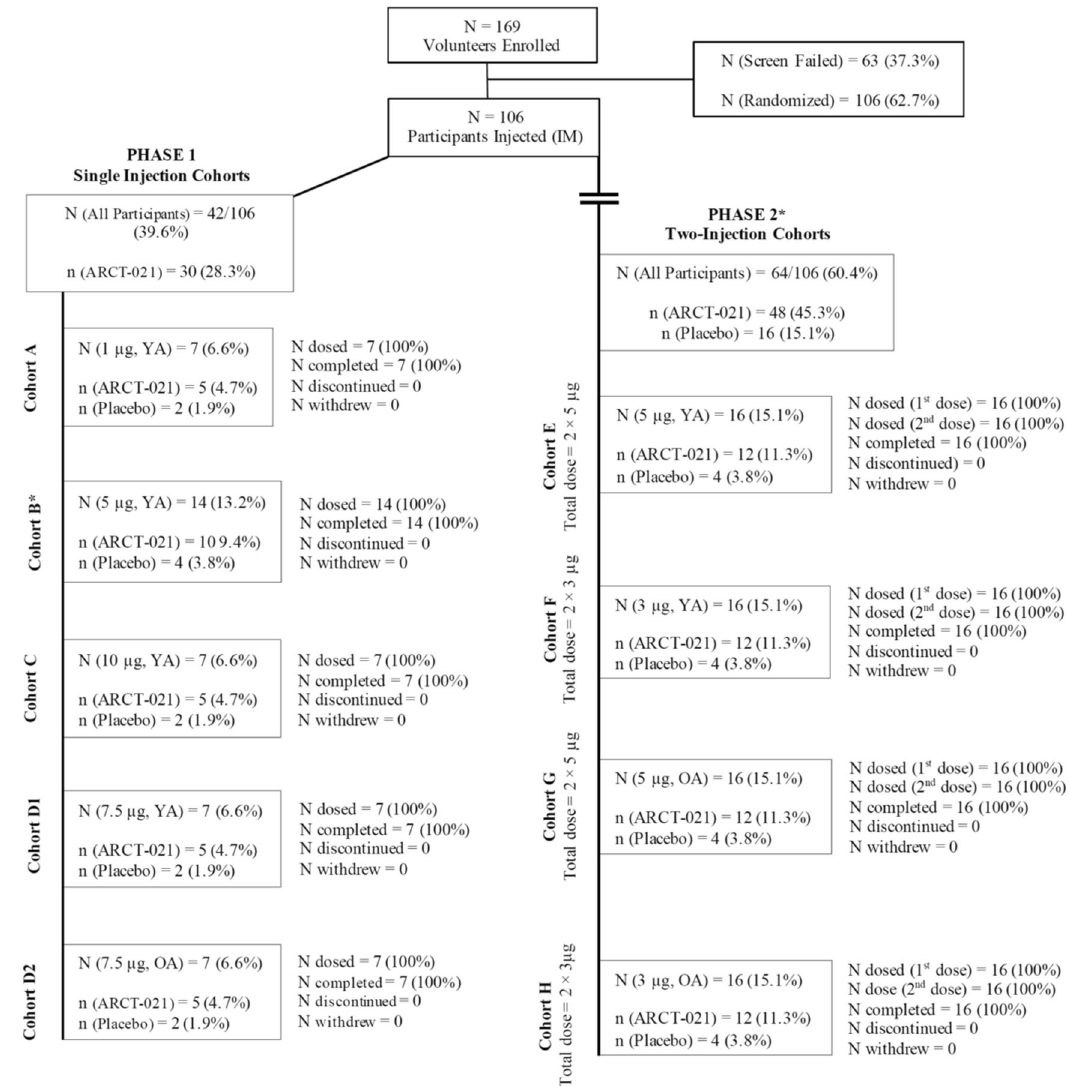
Fig. 1 Enrollment and randomization of trial participants. N number of participants in the cohort, n number of participants in each treatment group, OA older adults (56 – 80 years), YA younger adults (21 – 55 years). Phase 1 — Single injection, escalating dose. Study duration 56 days post fi rst injection. Phase 2 — Two same dose injections, 28 days apart. Study duration 85 days post fi rst